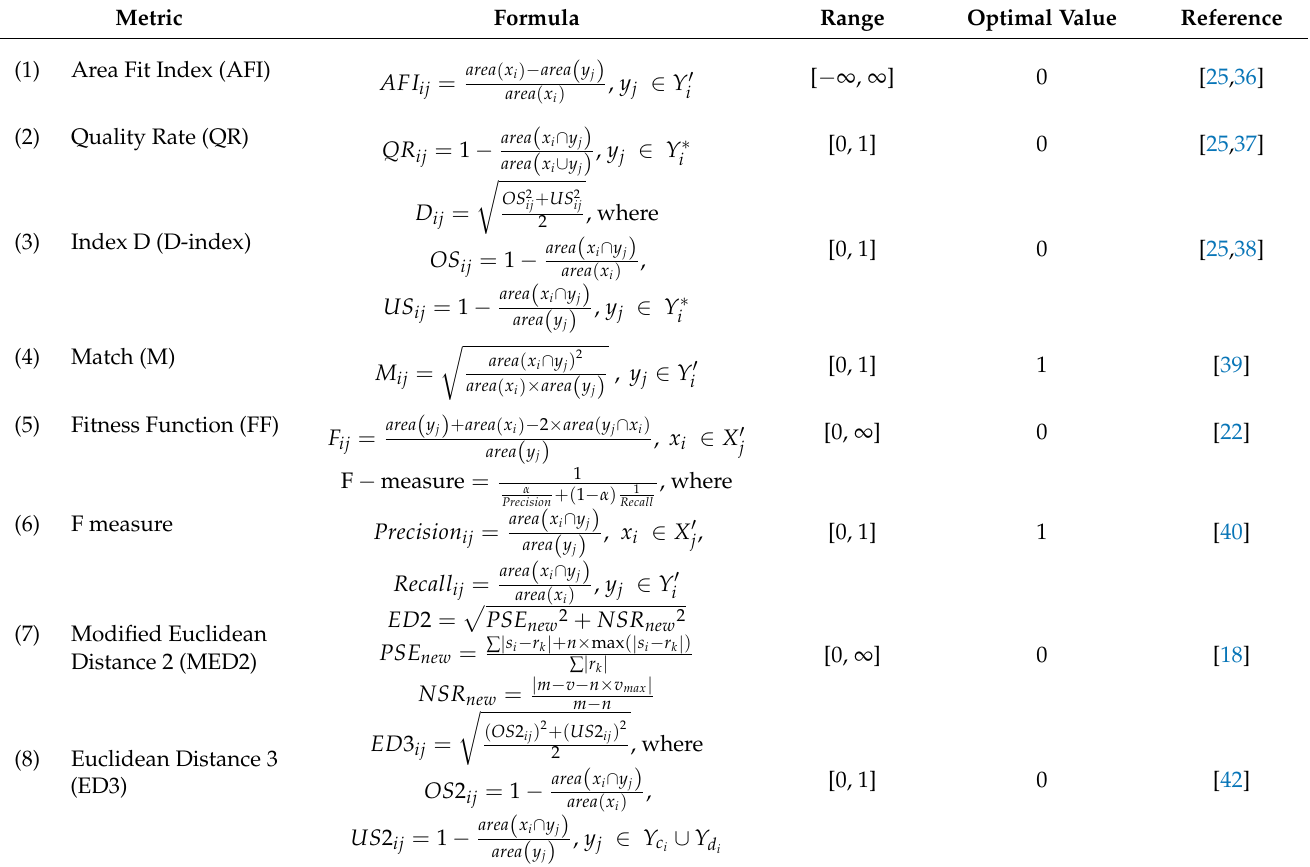
Table 1. Combined metrics evaluated in the